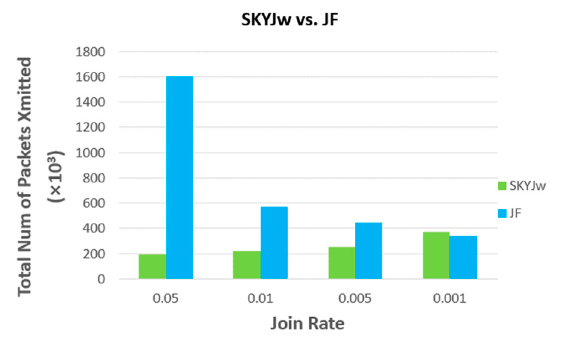
Figure 16. Comparison between SKYJw and JF for very low join rates.